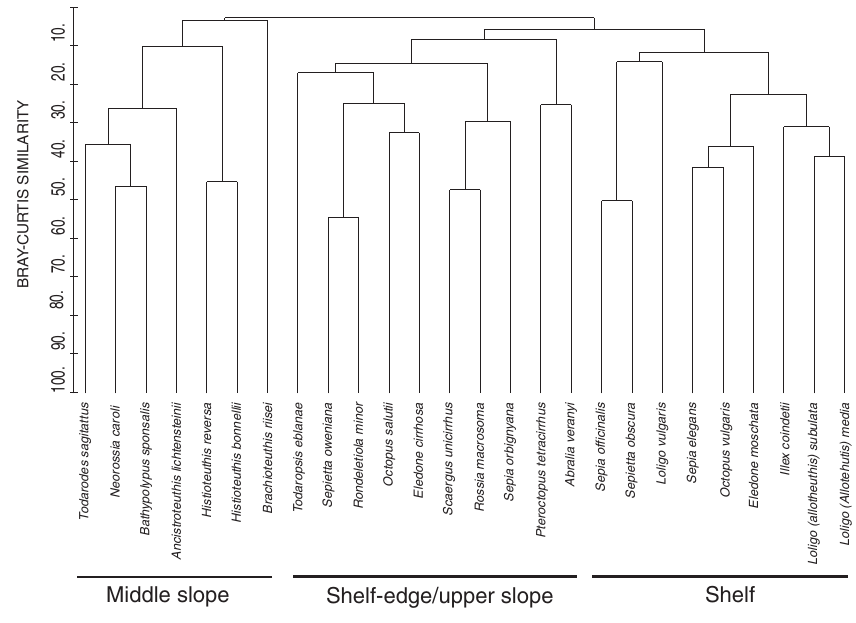
F IG . 3. – Dendrogram of the species relationships from the MEDITS-ES 96